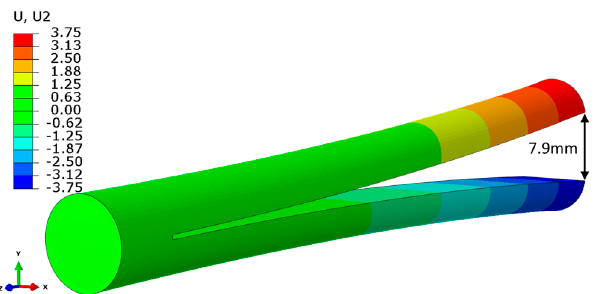
Figure 13. Deflection from the midplane (mm). Total distance between vertices is 7.9 mm with the account of removed material thickness of 0.4 mm.